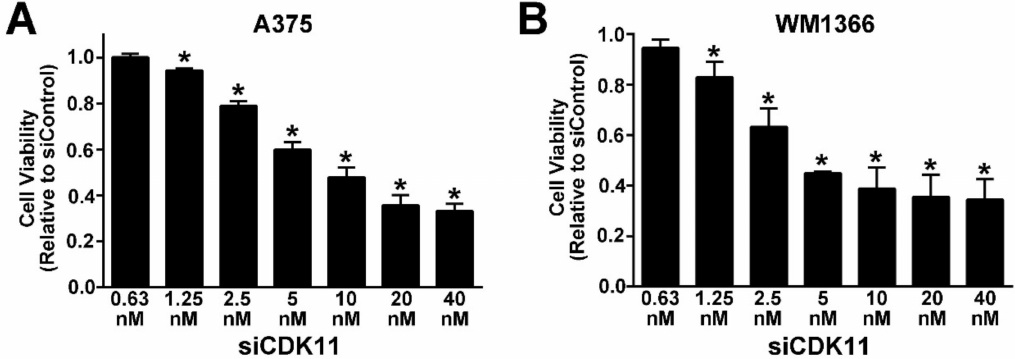
Figure 2. siRNA-mediated down-regulation of CDK11 in BRAF- and NRAS-mutant melanoma cells decreases cell viability. A375 ( A ) and WM1366 ( B ) cells were transfected with increasing concentrations of siRNA directed against CDK11. After 96 h, cell viability was determined relative to the siControl transfected cells. Means ± SE from three experiments are presented. * = p <